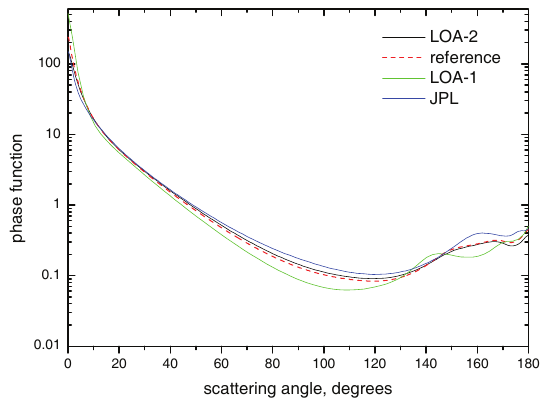
Fig. 15. The comparison of phase functions used/derived in re- trievals with the reference phase function (λ = 550nm ) for LOA-1,2, and JPL